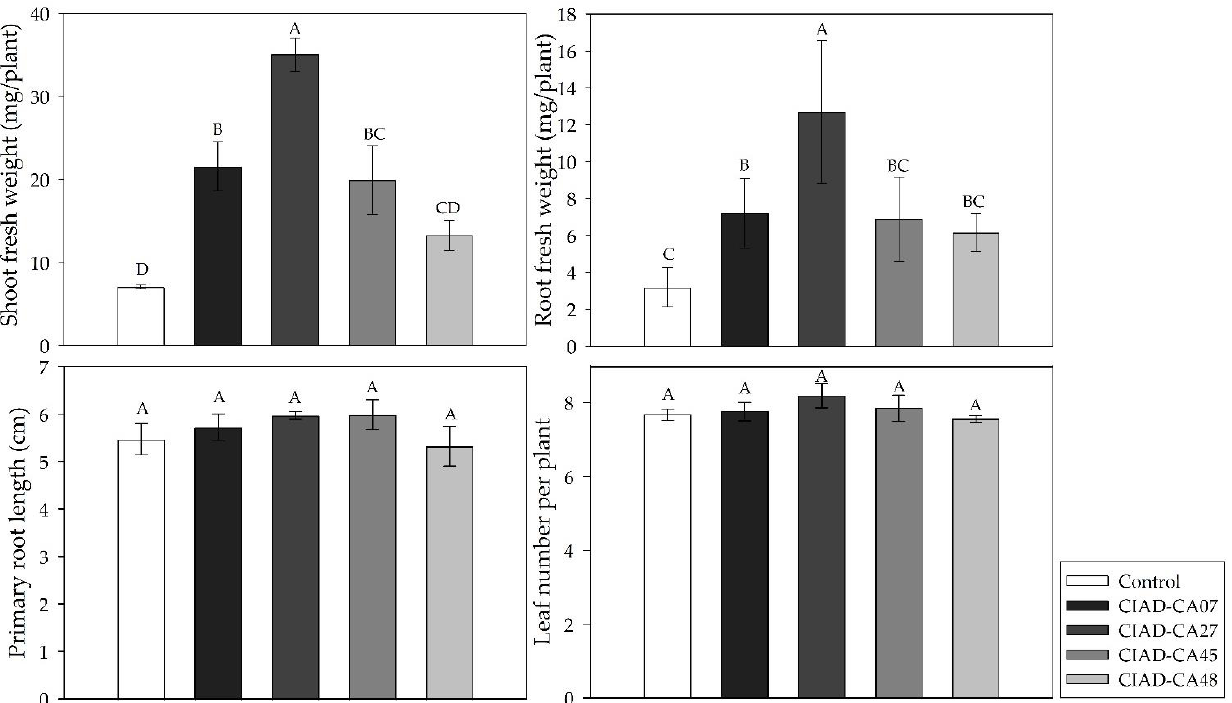
Figure 2. Effect of VOCs emitted by Streptomyces strains on biomass production in Arabidopsis thaliana seedlings. Mean values with the same letters are statistically similar. Thin upper bars indicate the standard deviations of the means.